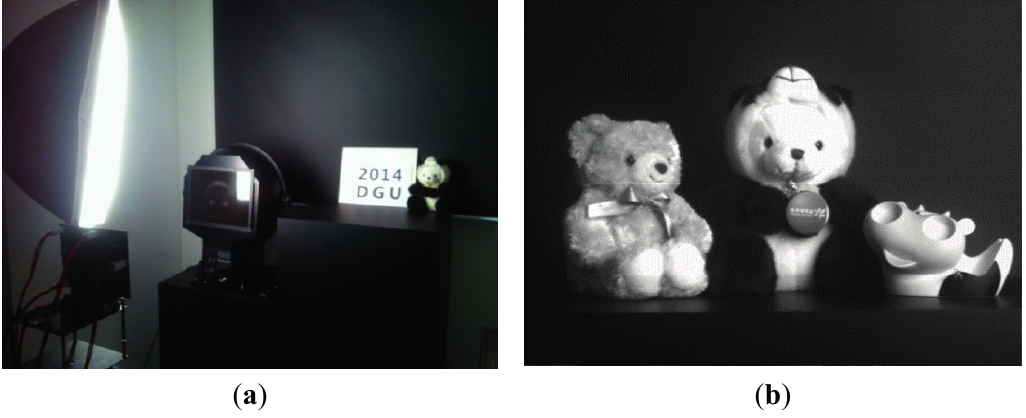
Figure 11. Measured results for the proposed CIS performance: ( a ) photograph of our dark room ( b ) measured VGA sample image with the proposed